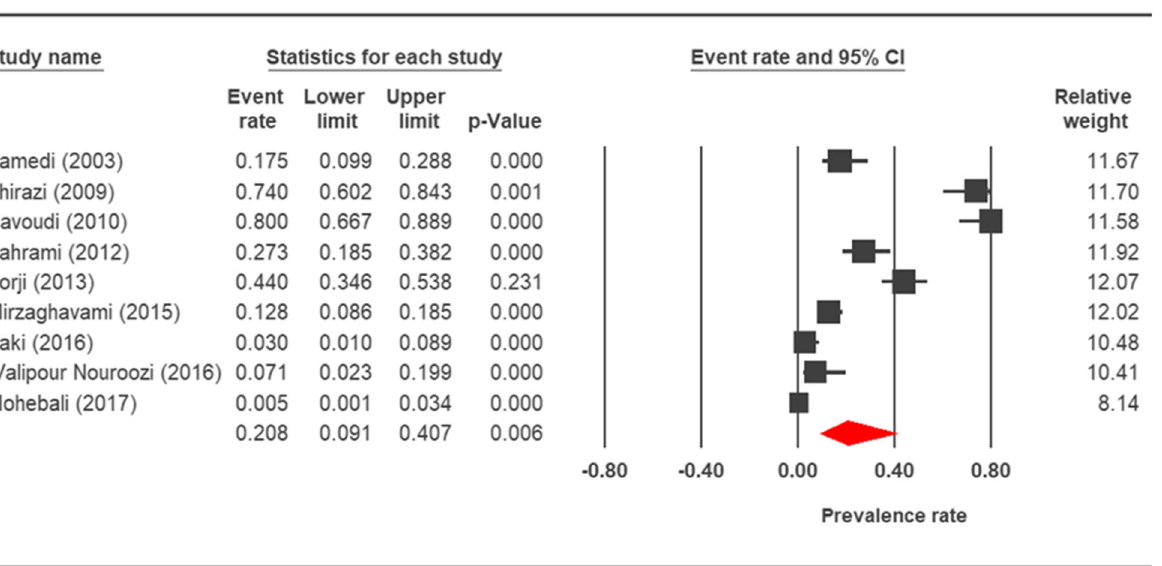
Fig. 4 Forest plot diagram showing the prevalence rate of Cryptosporidium infection in rodents of